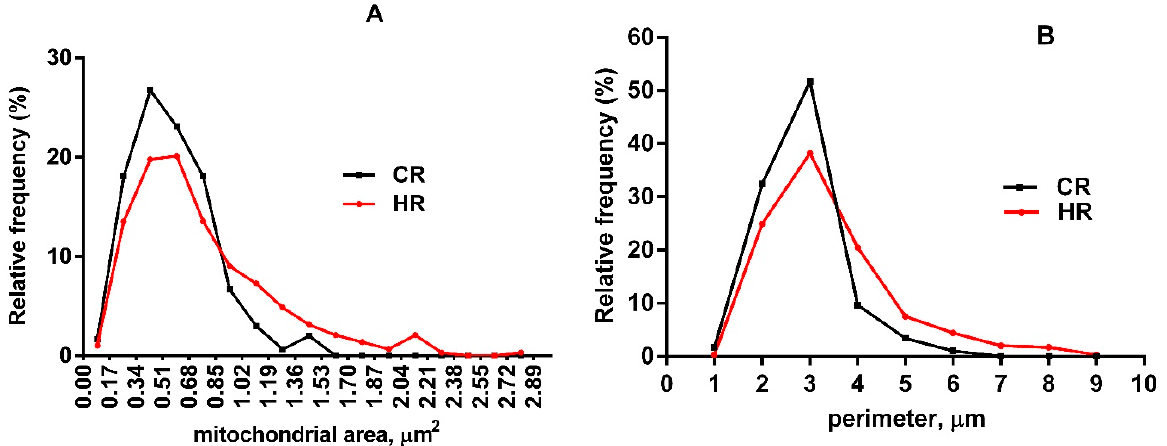
Figure 2. Morphometric parameters of liver mitochondria from experimental rats. ( A ) A histogram of distribution of the mitochondrial area in the groups. ( B ) A histogram of distribution of the mitochondrial perimeter in the groups. The number of mitochondria analyzed in each group varied from 500 to 600. CR, control; HR, hyperthyroidism. ( n = 3 in each group). Along with the data on the ultrastructure of liver mitochondria, we assessed the number of mtDNA copies by the PCR. As shown in Figure 3, administration of thyroxine caused a 20% increase in mtDNA levels of HR